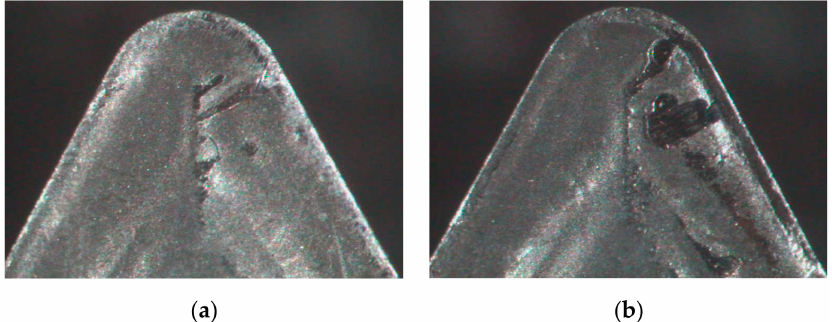
Figure 8. Stereoscopic optical microscopy (SOM) of the tool rake face (40 × ) after the tests performed for ( a ) f = 0.05 mm / r and ( b ) f = 0.10 mm / r, for v c = 40 m /